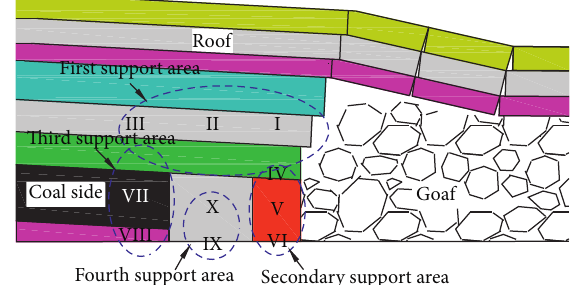
Figure 5: Support zone of thick-soft surrounding rock of deep gob- side entry retaining. I: the roof in filling area; II: the roof in roadway; III: the roof above solid coal side; IV: the zenith zone of filling body; V: the filling body; VI: the bottoming zone of filling body; VII: the middle and upper area of solid coal side; VIII: the lower area of solid coal side; IX: floor; X: